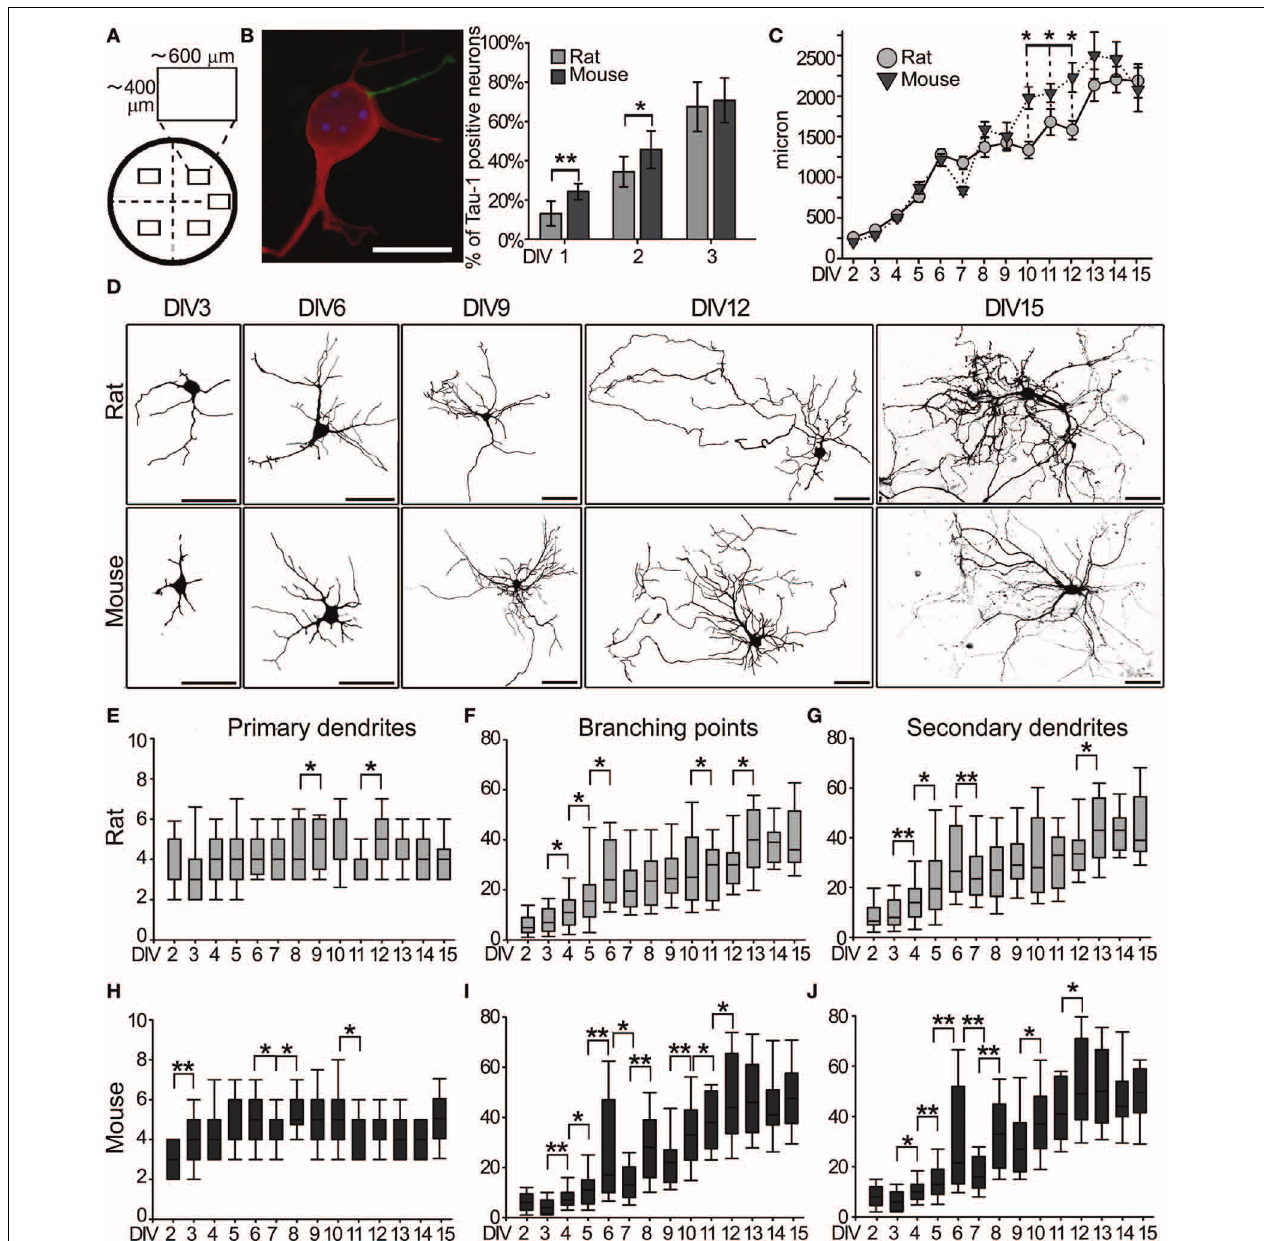
FIGURE 1 | Morphological characterization of rat and mouse hippocampal neurons. (A) Neurons were counted from five sampling areas (rectangles) per coverslip. (B) DIV2 mouse hippocampal neuron immunostained for MAP2 (red) and Tau-1 (green) and quantification (mean + s.e.m.) of the percentage of neurons with one Tau-1 positive/MAP2-negative neurite in mouse and rat neuronal cultures. (Scale Bar = 10 µ m) (C) Quantitative data of the average total dendritic length of mouse and rat hippocampal neurons in vitro . Data